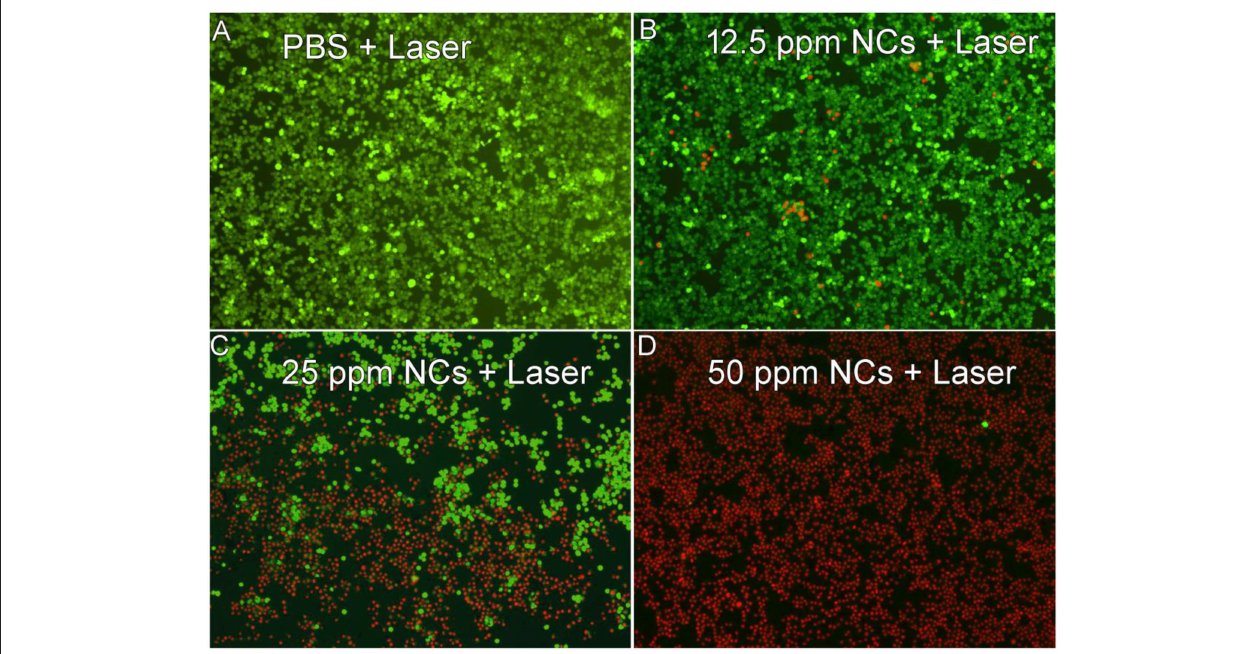
FIGURE 3 | Live/dead cell staining analysis after incubation with CMO NCs at indicated concentrations: (A) PBS, (B) 12.5ppm, (C) 25 ppm, (D) 50ppm, and then under the exposure of an 808nm (0.3 W/cm − 2 ) for 5min. Magnification: 100 times.